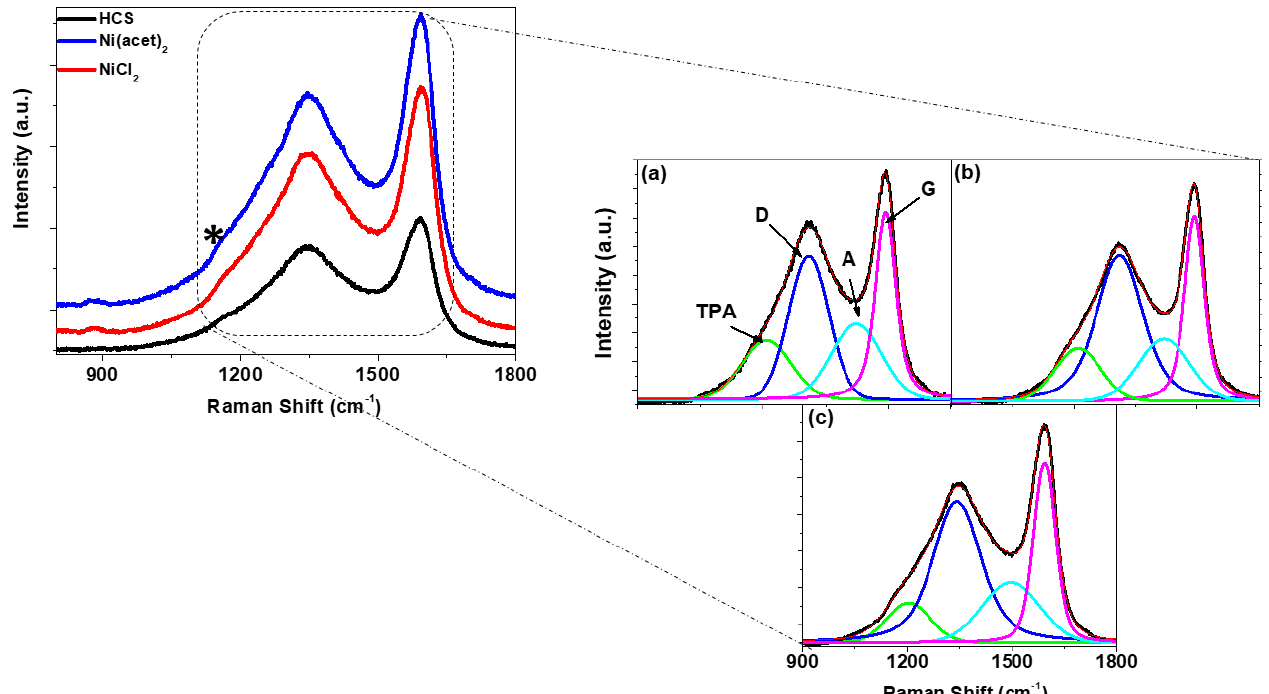
Figure 7: Peak-fitted Raman spectra of ( a ) pristine HCSs, and Ni@HCSs samples using ( b ) Ni(acet) 2 and ( c) NiCl 2 , precursors.